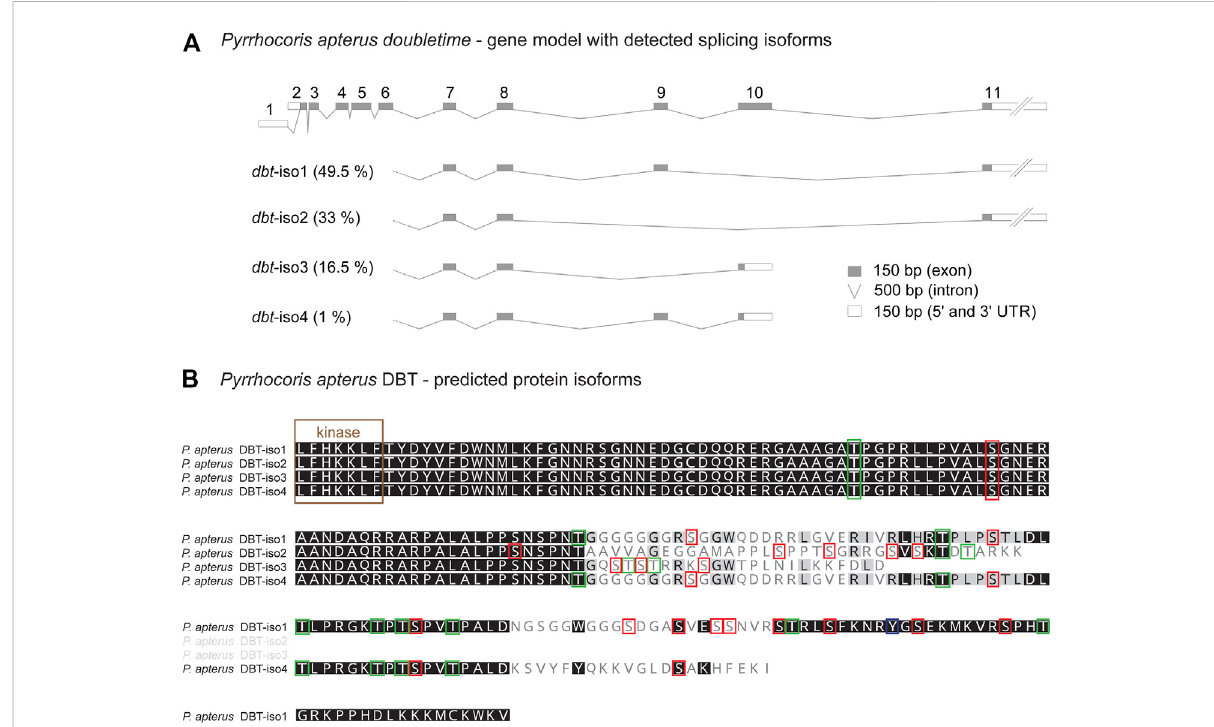
Alternative splicing of doubletime ( dbt ) gene in the linden bug Pyrrhocoris apterus . (A) A gene model illustrating the length of all dbt exons and introns. Two alternative transcription starts and splicing at the 5 ’ end (exon 1 or 2, respectively) do not in fl uence the predicted protein coding sequence. Alternative skipping of exons 9 and/or 10 results in four isoforms ( dbt -iso1, 2, 3, 4). The expression level of each dbt isoform mRNA in the brain was detected from the Oxford nanopore transcriptome and depicted as % contribution to all dbt molecules (100% — all isoforms).